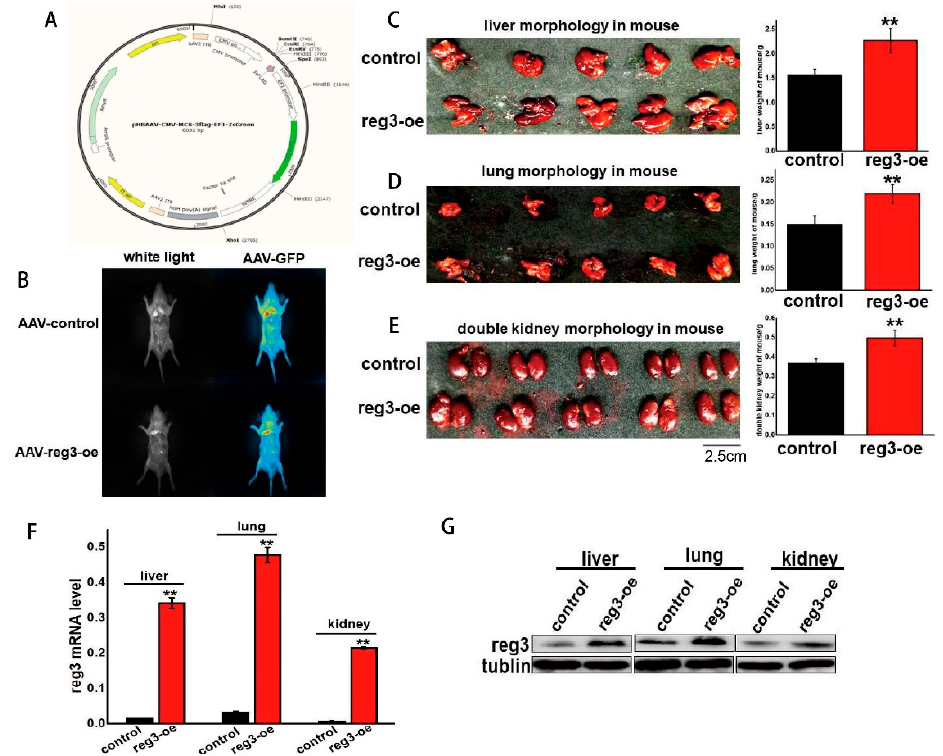
Figure 3. reg3 regulates the growth and development of tissues and organs. ( A ). The viral vector map of adeno-associated virus overexpressing reg3 (AAV-Reg3-oe). ( B ). The expression of reg3 was assessed using a small animal imaging instrument. ( C ). The mice were dissected, and the growth of the liver was assessed. ( D ). The mice were dissected, and the growth of the lungs was assessed. ( E ). The mice were dissected, and the growth of the kidneys was assessed. ( F ). The mRNA level of reg3 in each tissue and organ was assessed. ( G ). The protein level of reg3 in each tissue and organ was assessed. ** p value ≤ 0.01